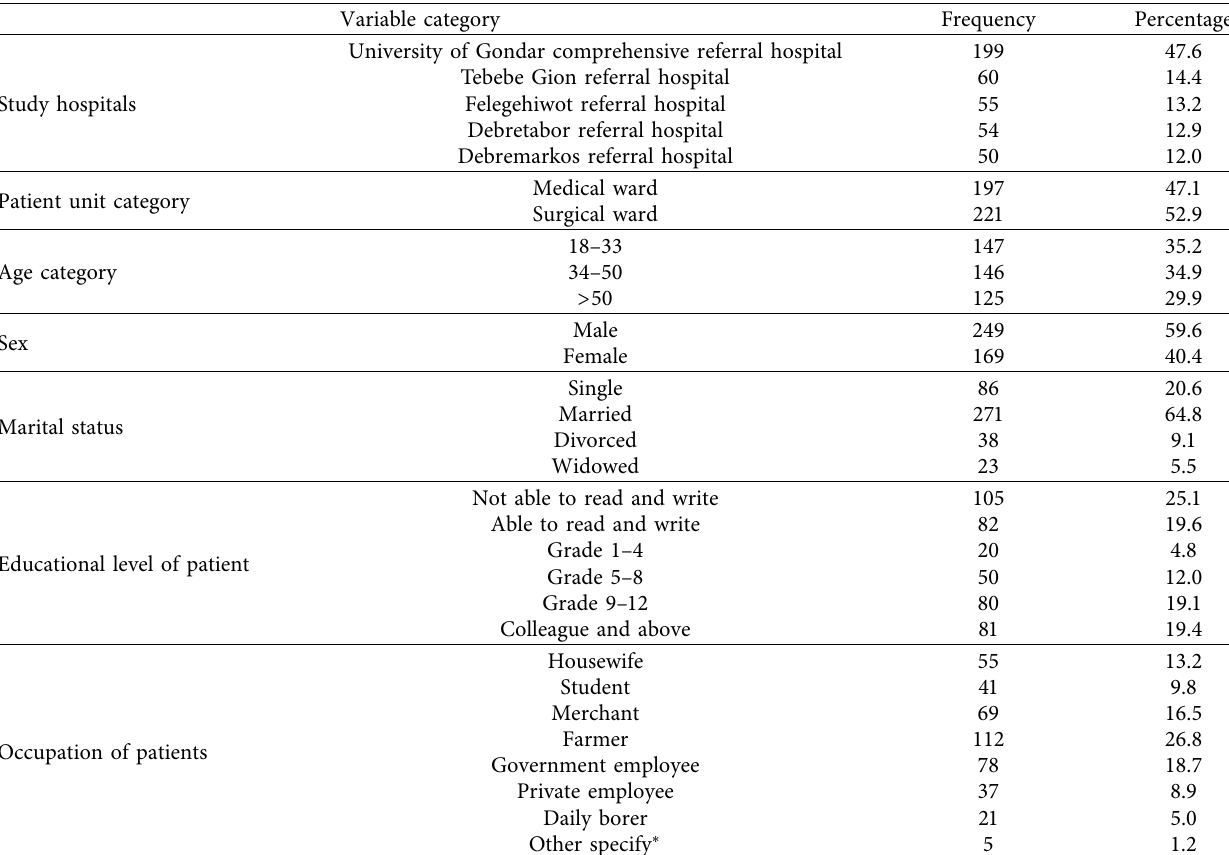
Table 1: Sociodemographic characteristics of participants to assess the incidence and associated factors of failed first intravenous catheter